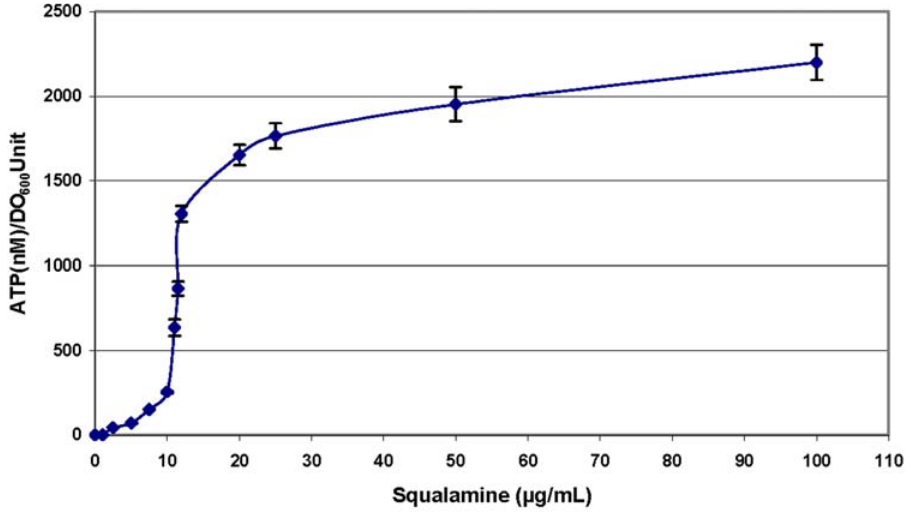
Figure 3. Measurement of squalamine concentration effect on E.coli ATP efflux. doi:10.1371/journal.pone.0002765.g003 PLoS ONE |